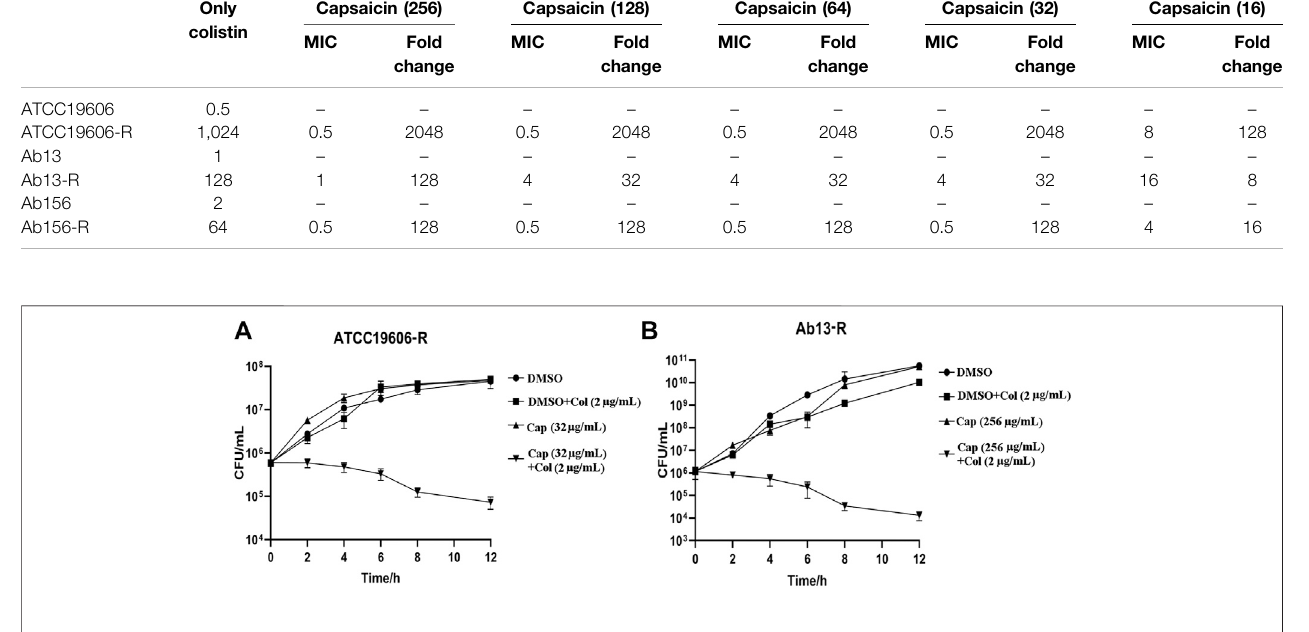
TABLE 2 | Colistin MICs of wild-type and laboratory-generated colistin-resistant strains when treated with different concentrations of capsaicin. Strain Only colistin